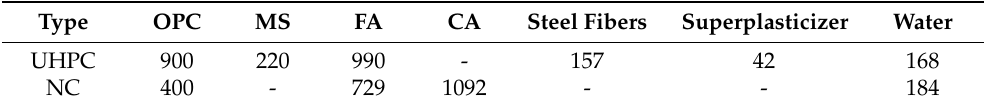
Table 3. Mixture Proportions of UHPC and NC (kg/m 3 ).